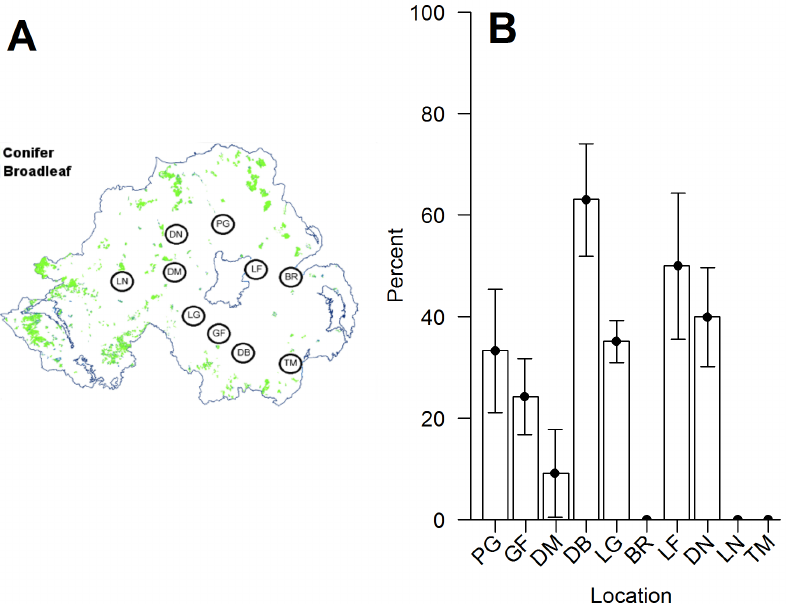
Figure 1. (A) Distribution of sampling locations across various forests in N.I. (B) Percentage of specimens ( 6 S.E.) found to be positive for squirrelpox virus within each location. Forest locations are denoted as: PG – Portglenone; GF – Gosford; DM – Drum Manor; DB – Drumbanagher; LG – Loughgall; BR – Belvoir; LF – Larchfield; DN – Derrynoyd; LN – Lissan; TM – Tollymore.